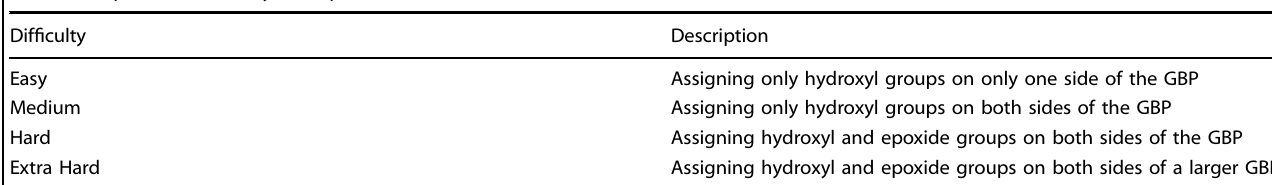
Table 2. Experiment dif fi culty descriptions.